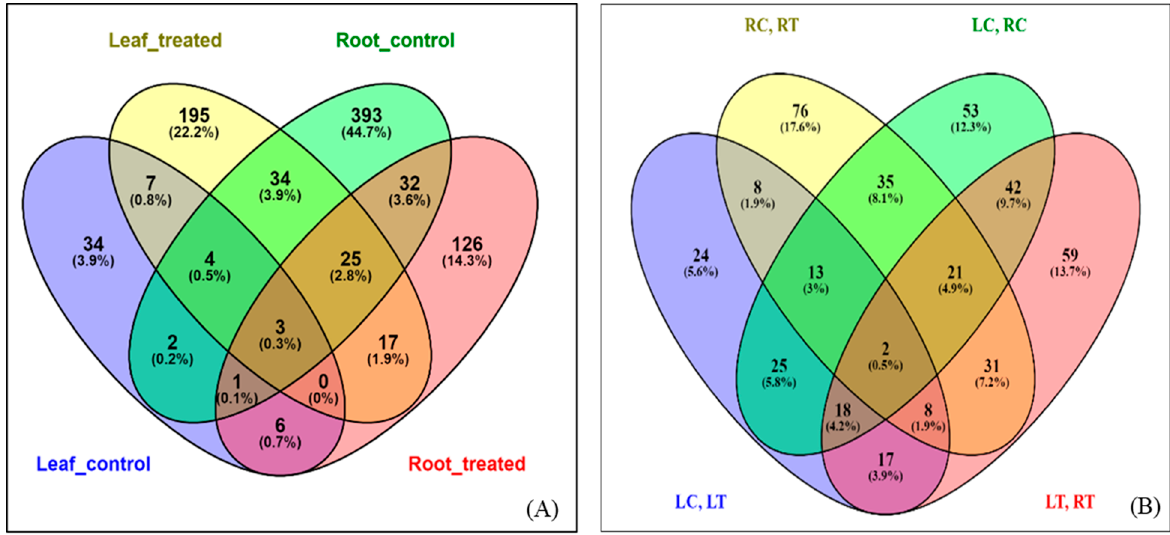
Figure 4. Venn diagram representing shared and unique ( A ) lncRNAs under four conditions and ( B ) differentially expressed lncRNAs in four comparisons.